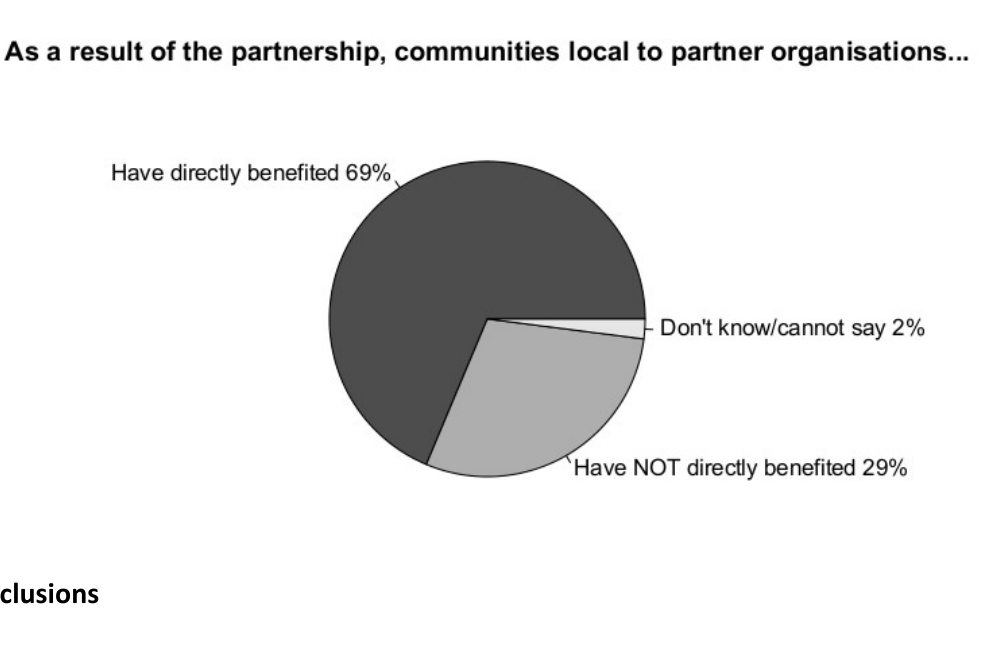
Figure 14. Claimed positive impact of museum university partnerships on community local to partner organisations as shown by survey